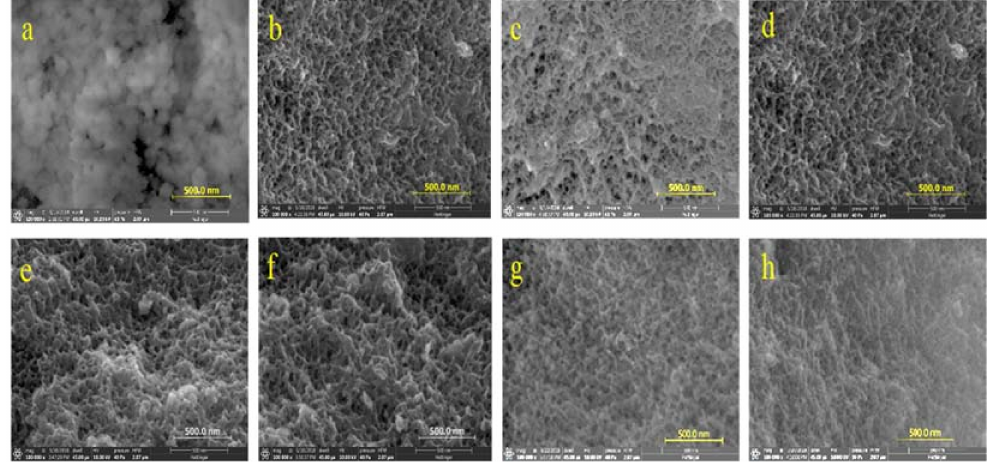
Figure 3. SEM of various samples: ( a ) RF ( b ) M-RF ( c ) Co1-M-RF ( d ) Co3-M-RF ( e ) Co5-M-RF( f ) Co3-H-RF ( g ) H-RF ( h )